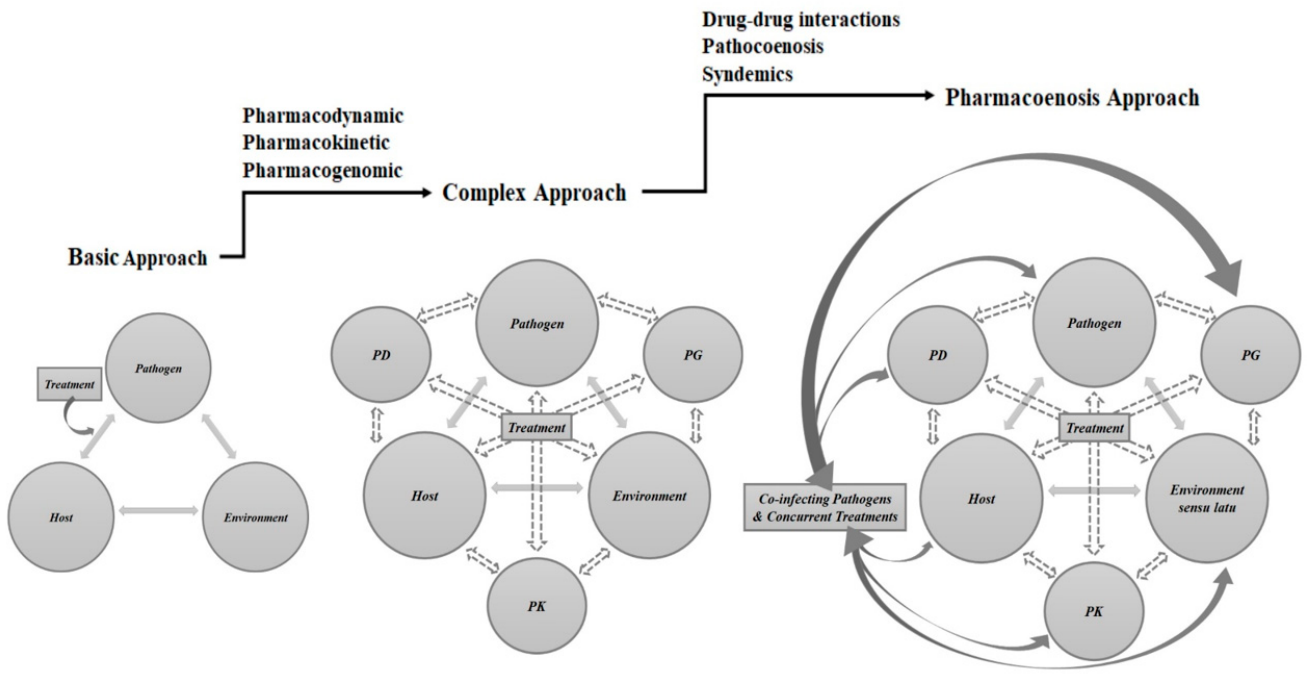
Figure 1. Schematic representation of medical approaches to infectious diseases: the traditional approach, the transitioning approach upgraded by pharmacological considerations that have to be taken into account when prescribing and administering anti-infective drugs and the pharmacoenosis model that tries to tailor the anti-infective treatment based on classical factors (host and pathogen), pharmacological factors, and on potential boosting effects and overlapping benefits of concurrent treatment, infections, and comorbidities. Legend: PD, pharmacodynamics; PG, pharmacogenomics; PK, pharmacokinetics.